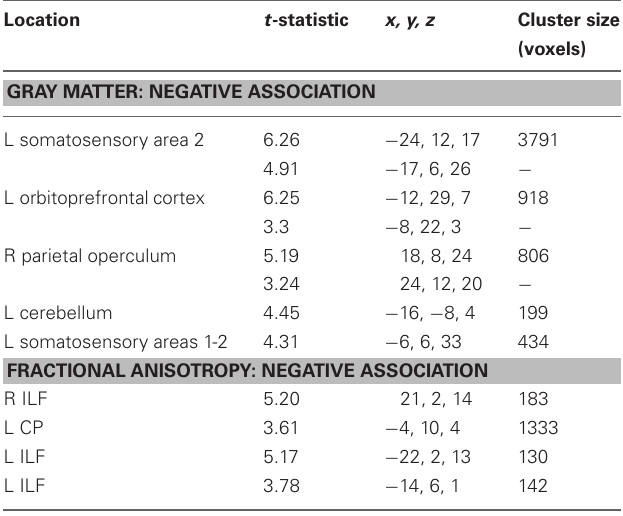
Table 2 | Regions where perseverative error rate was significantly correlated with gray matter volume and fractional anisotropy in voxel-wise